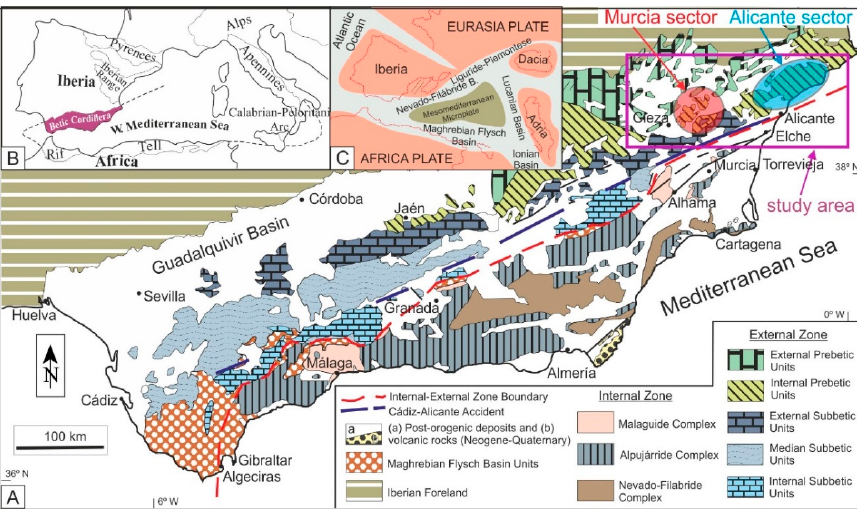
Figure 1. The Betic Cordillera (after Reference [19]; modified). ( A ) Geological map of the Betic Cordillera with the location of Cenozoic Basins of the eastern External Betic Zone (EBZ) (study area), the Murcia (Figure 2) and Alicante (Figure 3) sectors. ( B ) Geographic location of the Betic Cordillera in the context of the western Mediterranean alpine chains. ( C ) Paleogeographic sketch of the western Mediterranean area during the Cretaceous.